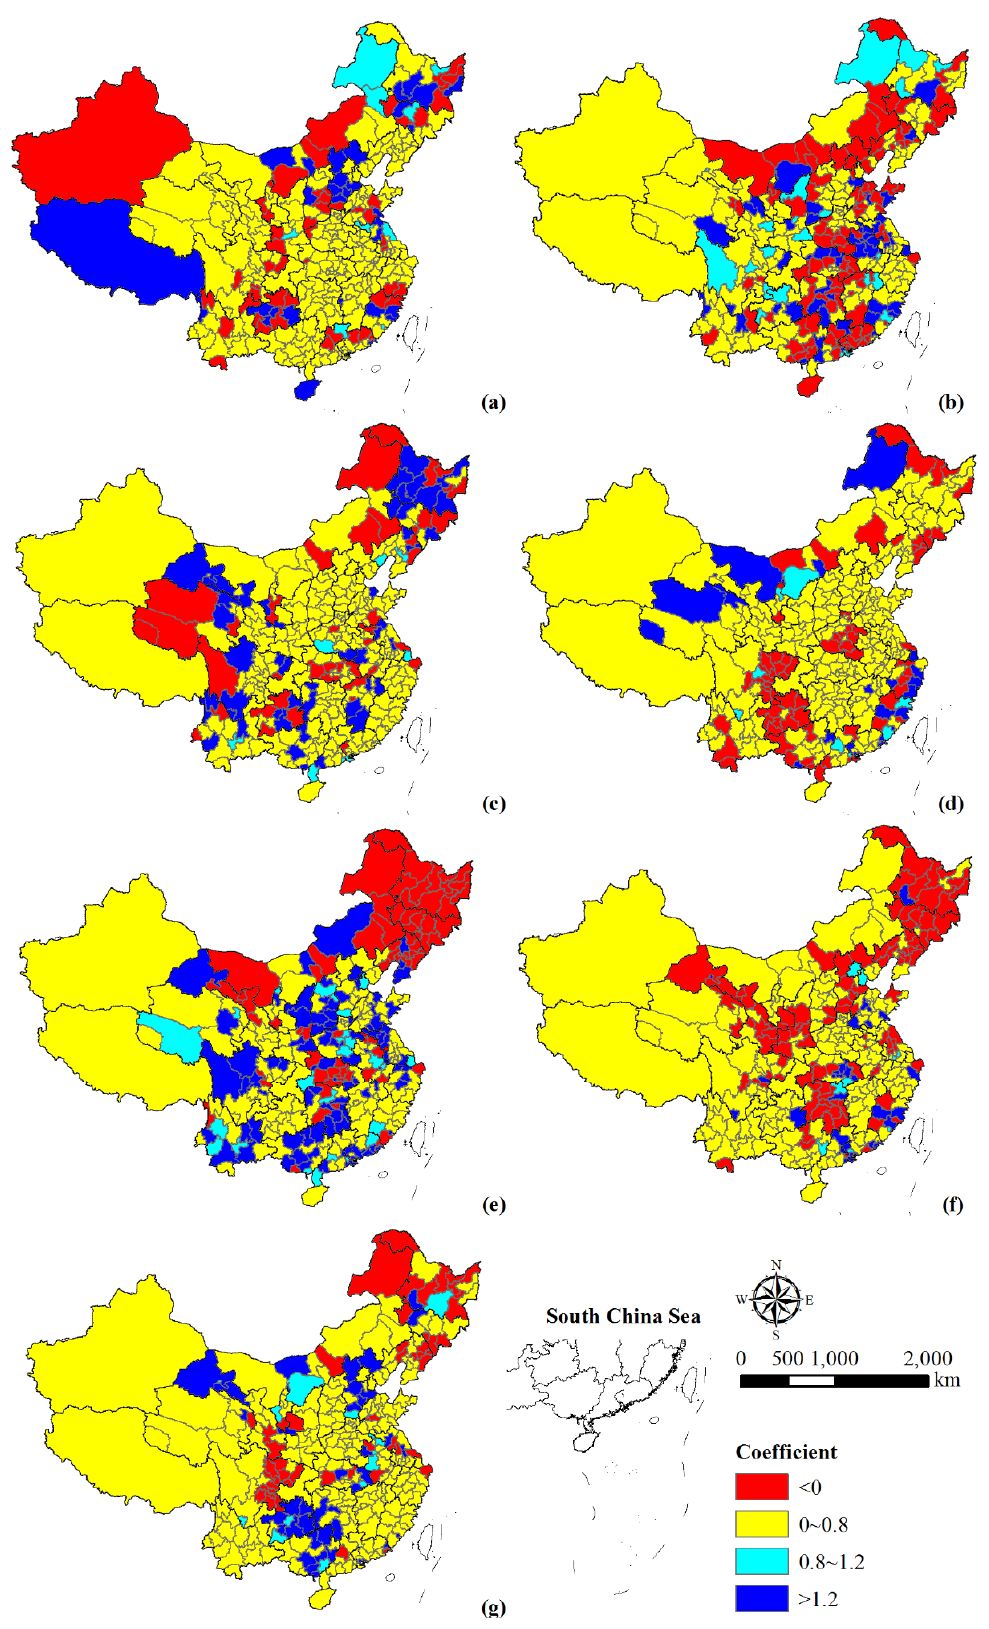
Figure 7. Spatial variation of the elasticity coefficient between population and construction land during 1990–1995 ( a ), 1995–2000 ( b ), 2000–2005 ( c ), 2005–2010 ( d ), 2010–2015 ( e ), 2015–2018 ( f ), and 1990–2018 ( g ).